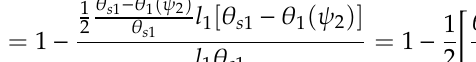
Table 4. Parameters of the new, modified Green-Ampt model for the laboratory infiltration